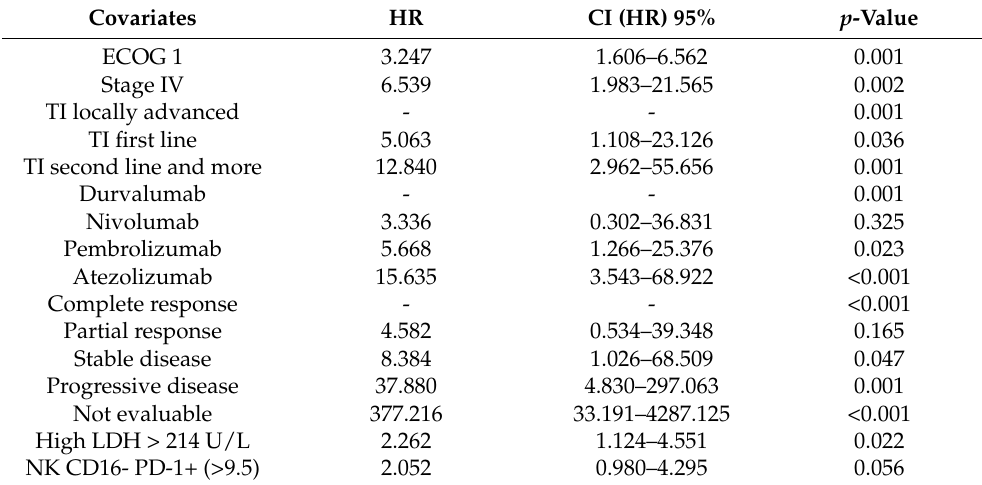
Table 4. Individual coefficients of the variables included in the Cox regression.